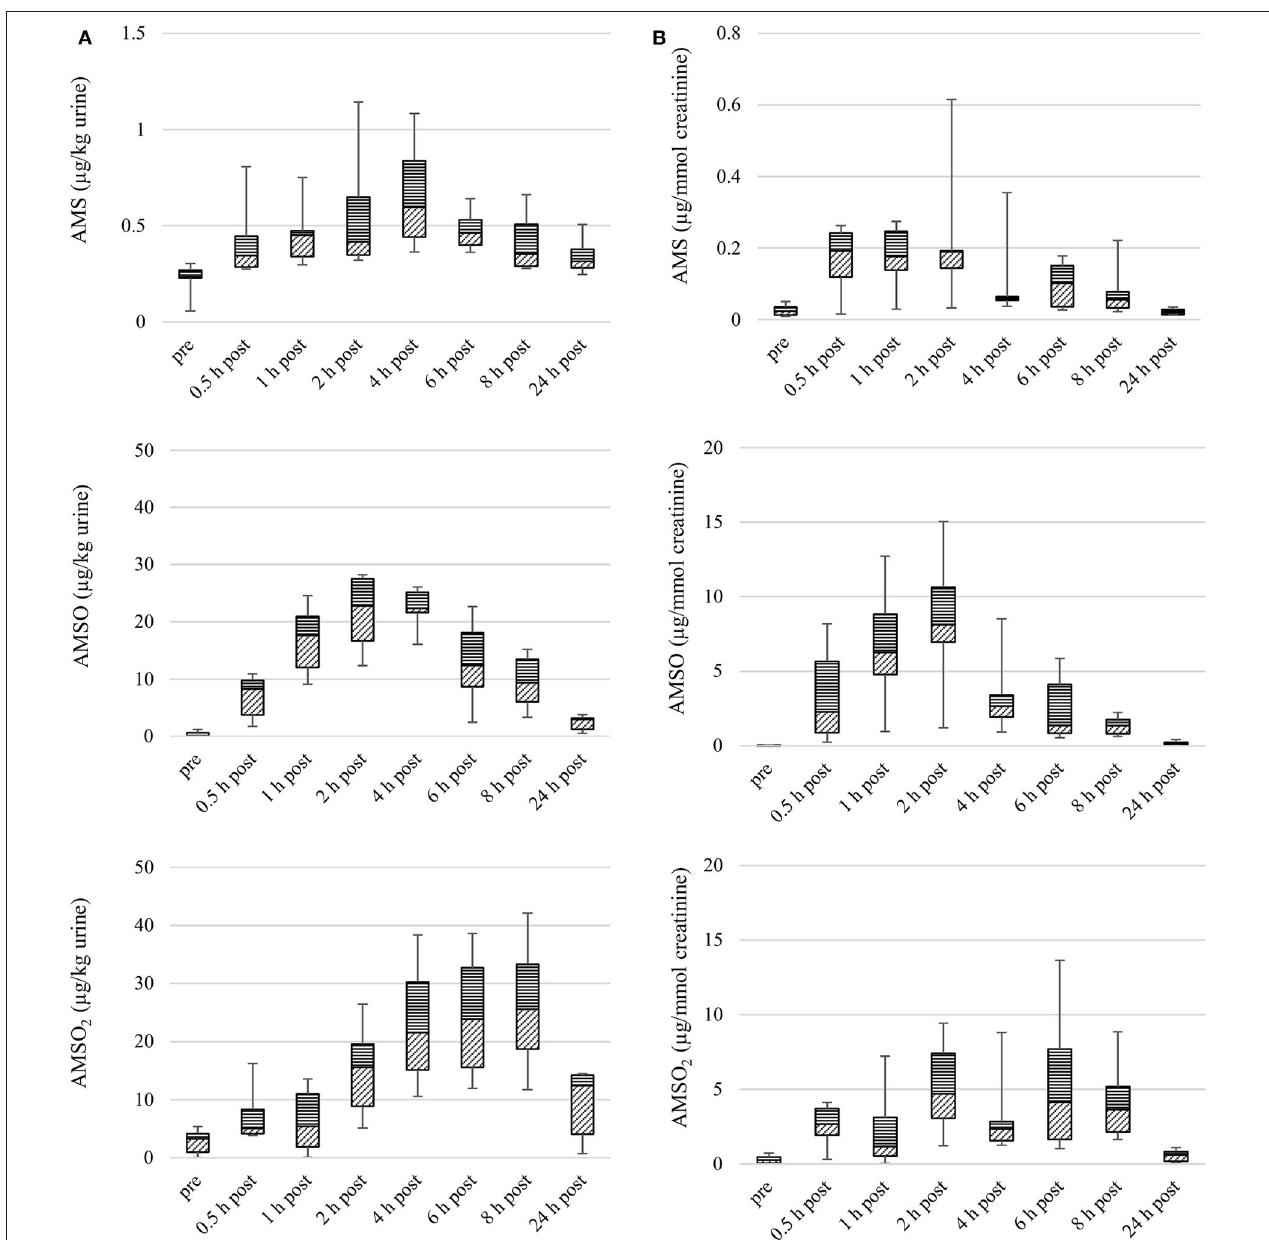
FIGURE 2 | Box plot (median value, markers at minimum and maximum metabolite concentration, box percentile 25–75) of garlic metabolite (AMS, AMSO, and AMSO 2 ) concentrations in urine, in µ g/kg (A) and µ g/mmol creatinine (B) . Data from six participants, urine samples obtained before (“pre”), or after (“0.5h post” to “24h post”) intake of cooked